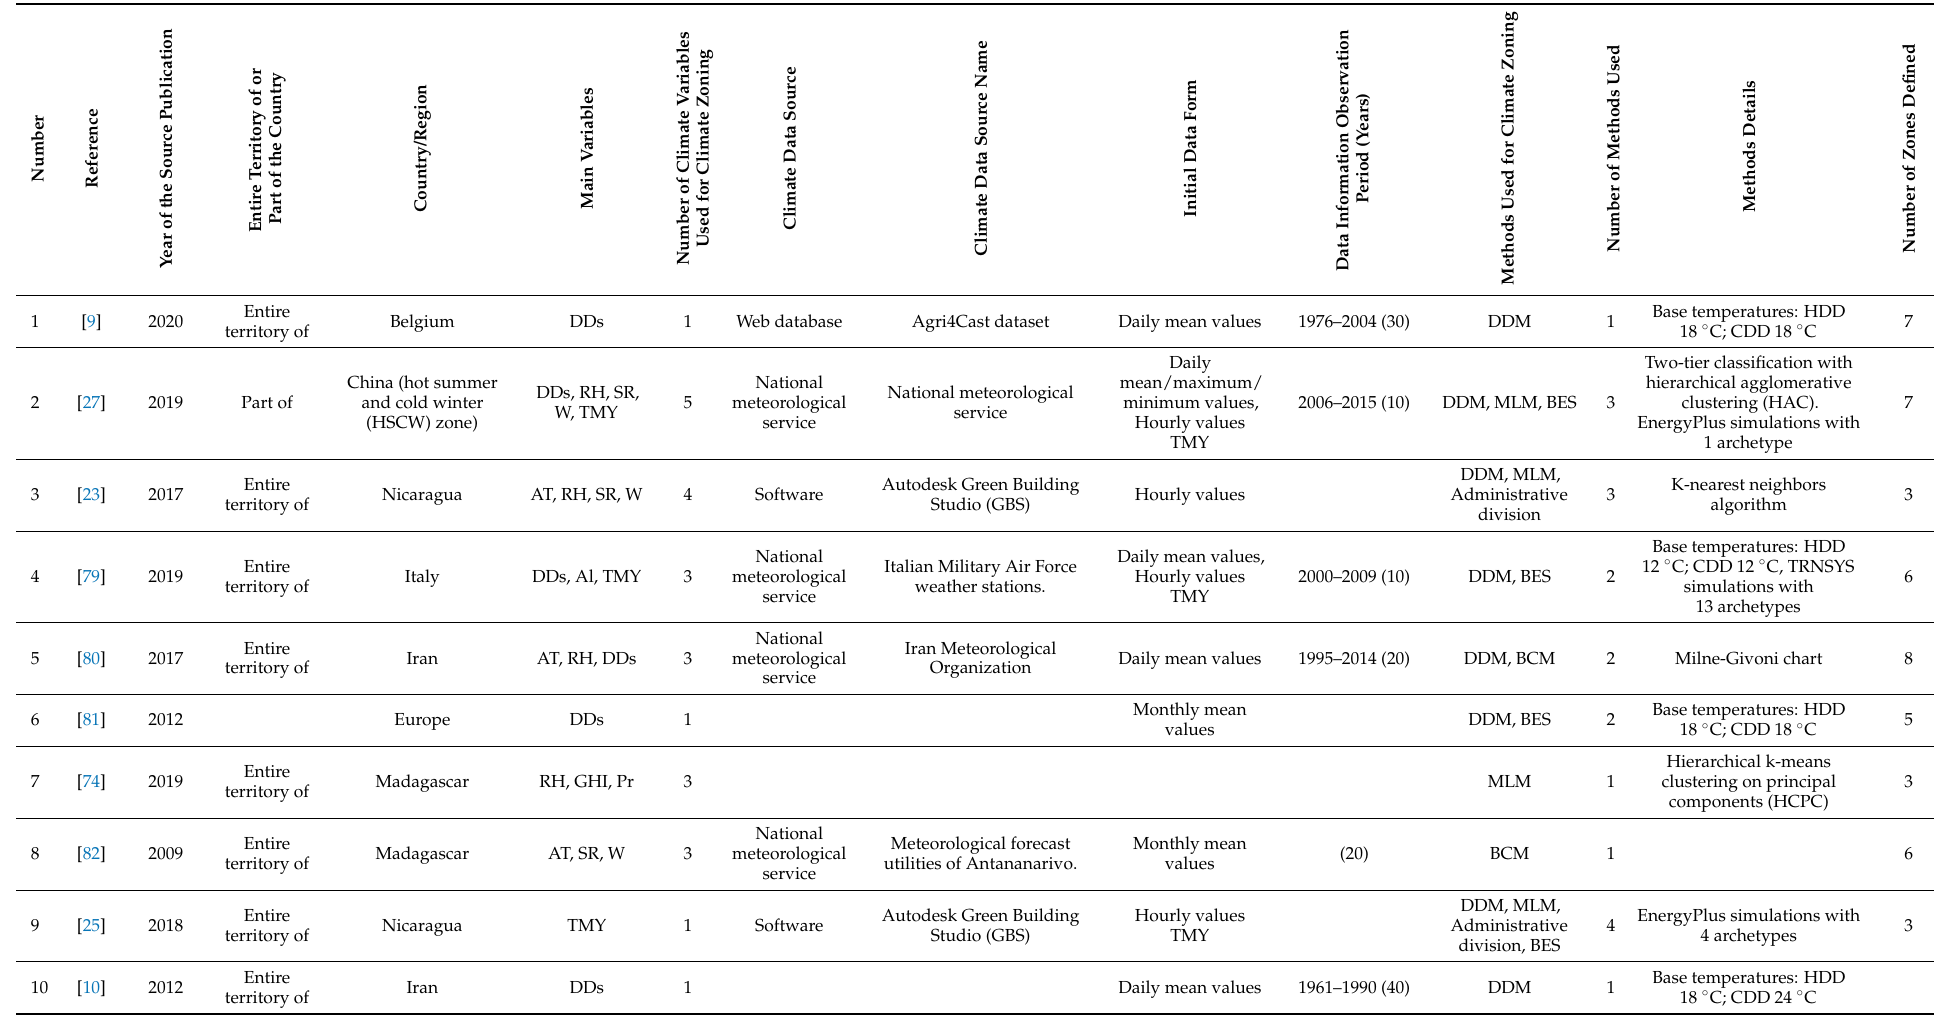
Table 1. Data collected during the